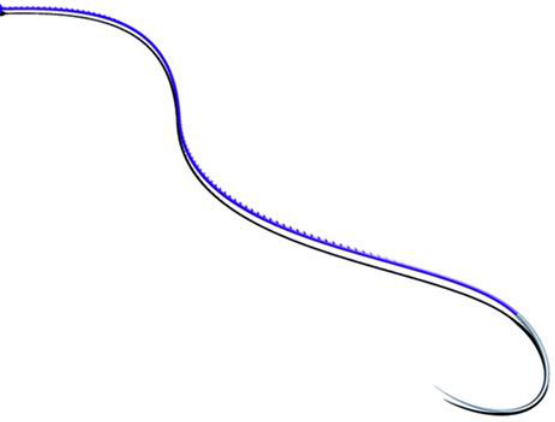
Figure 1. Knotless, synthetic, monofilament, absorbable barbed suture with a button final lock system (Filbloc, polydioxanone (PDO) monofilament long term absorption, Assut Europe, Roma, Italy).